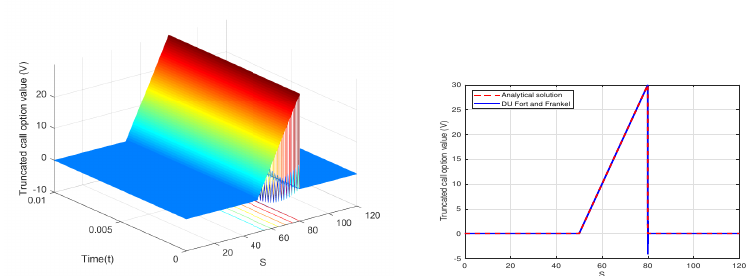
Figure 6. Spurious oscillations in the solution provided by the Du Fort and Frankel method with ∆ S = 0.01, ∆ t = 10 − 4 . Parameter values: r = 0.07, σ = 0.001, T = 0.01, U = 80, K = 50, L = 20, S max = 120.